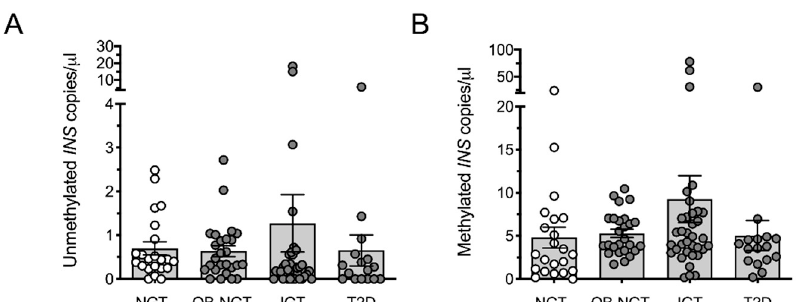
Figure 2. Circulating unmethylated and methylated INS DNA in lean adults with normal glucose tolerance (NGT) adults with obesity with normal glucose tolerance (OB-NGT), obesity with impaired glucose tolerance (IGT), and obesity with type 2 diabetes (T2D). ( A ) Circulating unmethylated INS DNA; ( B ) methylated INS DNA. A Kruskal-Wallis (non-parametric) test was employed followed by a Dunnett’s post-test (to compare values to NGT controls). Statistical significance was assumed at p < 0.05. Data are presented as mean ±